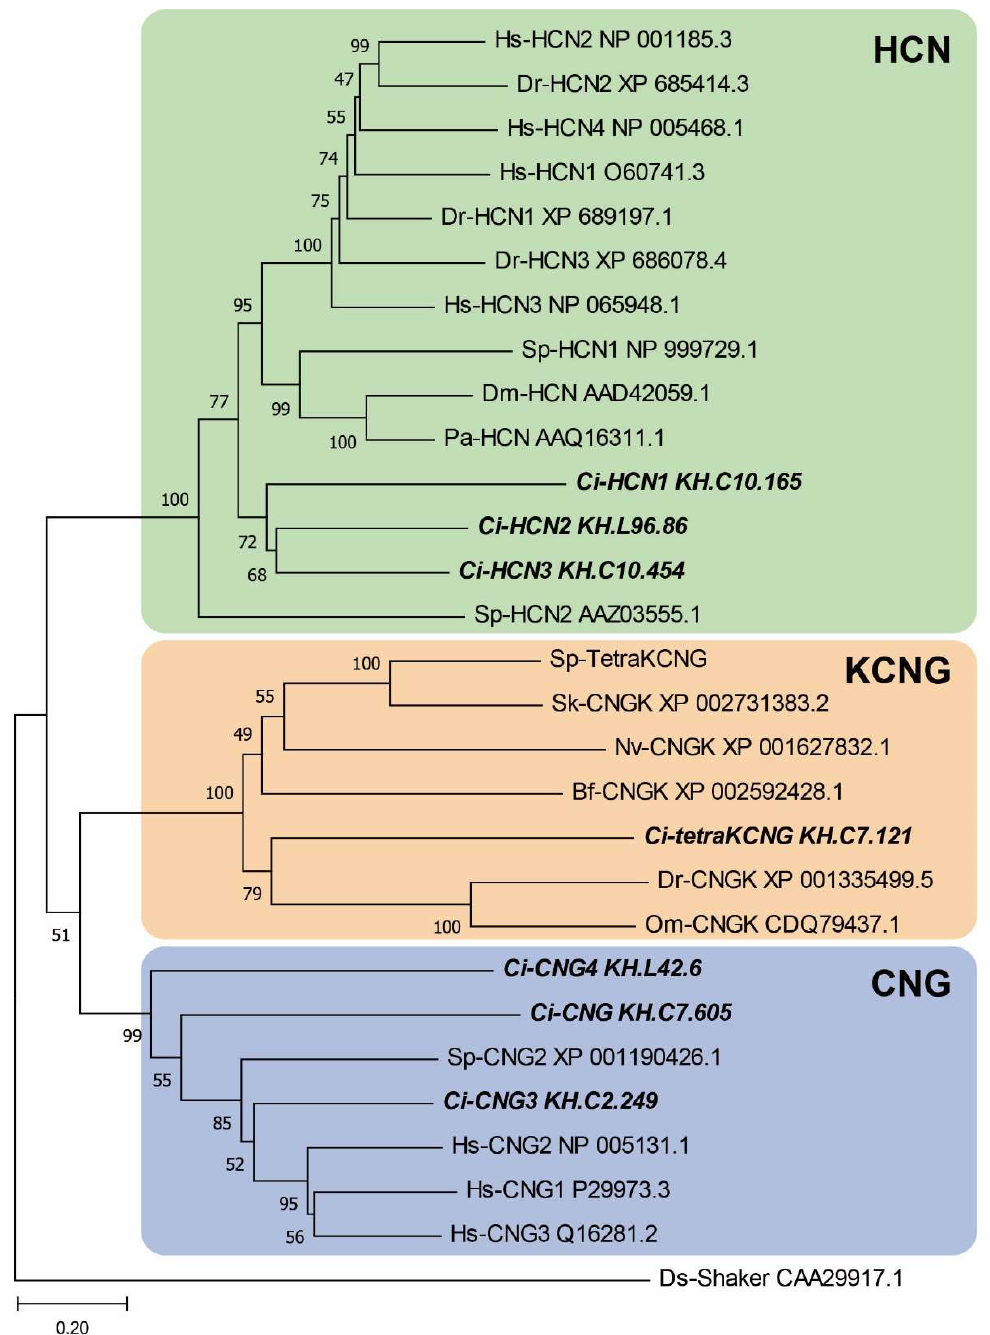
Figure 1. Phylogenetic analysis of cyclic nucleotide-gated channels from Ciona , sea urchins and other animals. The following ion channel sequences were used for the alignment: the HCN channel from Ciona (Ci-HCN1, 2, 3), sea urchin (Sp-HCN1, 2), human (Hs-HCN1, 2, 3, 4), zebrafish (Dr-HCN1, 2, 3), fruit fry (Dm-HCN), spiny lobster (Pa-HCN); the CNG channel from Ciona (Ci-CNG, 3, 4), sea urchin (Sp-CNG2), human (Hs-CNG1, 2, 3); CNGK channels from Ciona (Ci-tetraKCNG), sea urchin (Sp-tetraKCNG), acorn worm (Sk-CNGK), amphioxus (Bf-CNGK), starlet sea anemone (NvCNGK), zebrafish (Dr-CNGK) and rainbow trout (OmCNGK). The Drosophila shaker channel (Ds-Shaker) was used as an outgroup. The value on each branch represents the number of times that a node was supported in 100 bootstrap pseudoreplications. The Ciona KCNG channel (Ci-tetraKCNG; KH.C7.121) is a single polypeptide with four KCNG domains, each of which contains six transmembrane segments (S1 – 6), a K + -